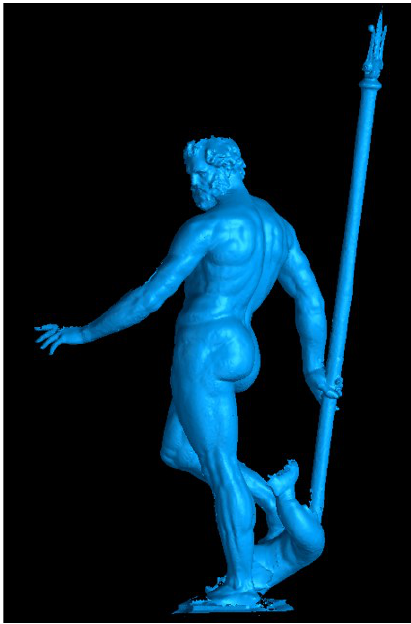
Figure 5. 3D model of the statue of